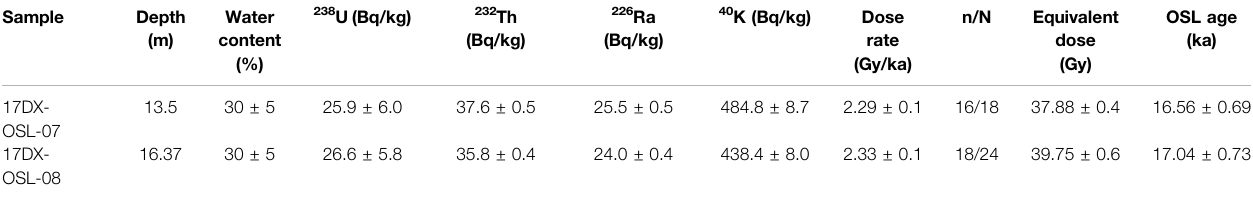
TABLE 3 | Results of OSL dating for the Diexi lacustrine sediments.